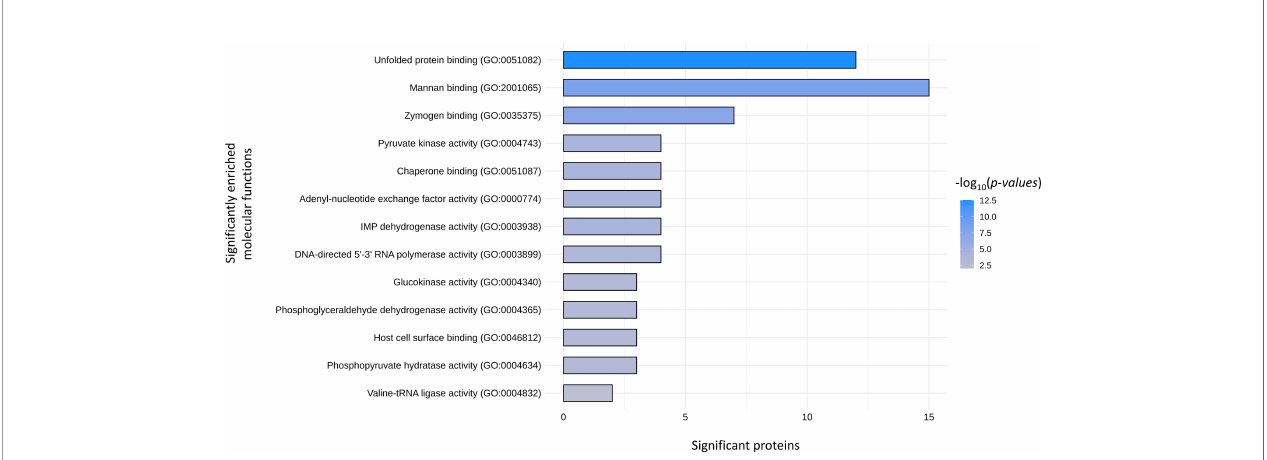
FIGURE 10 | Molecular function GOs signi fi cantly enriched in the EV derived proteins that are shared among S. aureus , E. faecium , E. faecalis and G.vaginalis . Raw data used for the plot are reported in Tables S1 – S11